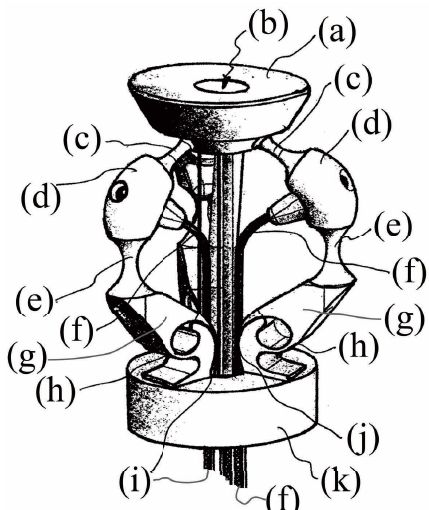
Figure 1. A view of the compliant platform and of all its elements: platform ( a ); plaform hole ( b ); type S elastic joints ( c ); type-U elastic joints ( e ); upper ( d ) and lower ( g ) links; upper ( f ) and lower cables ( i ); conjugate surface flexure hinge (CSFH) hinges ( h ); base link ( k